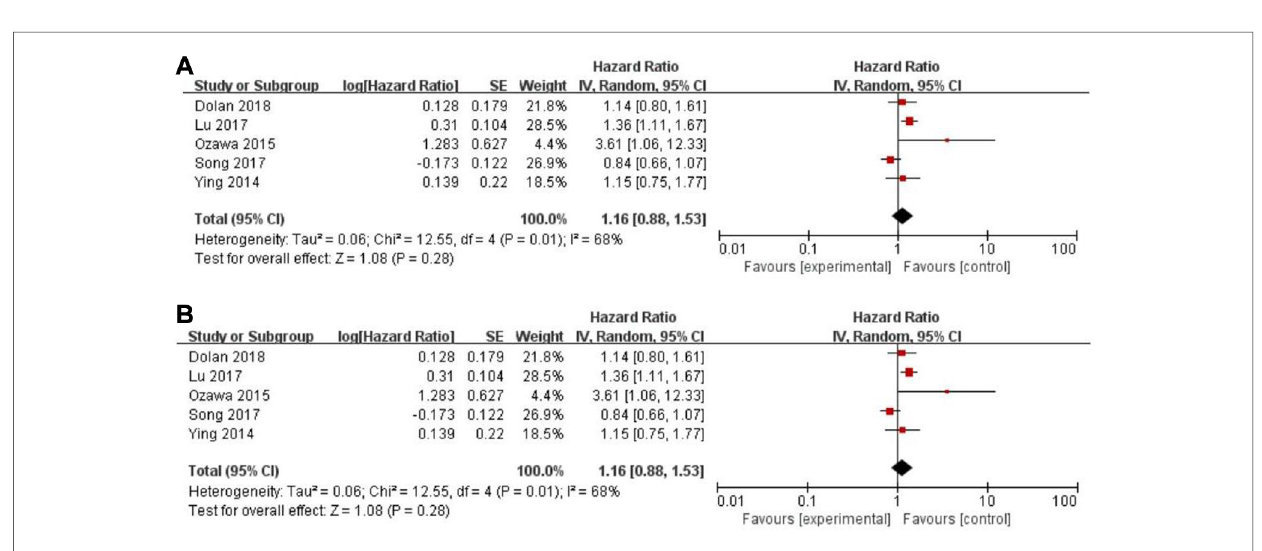
FIGURE 6 Forest graph on association of cancer-speci fi c survival with different levels of platelet-to-lymphocyte ratio groups. ( A ) random effect model. ( B ) fi xed effect